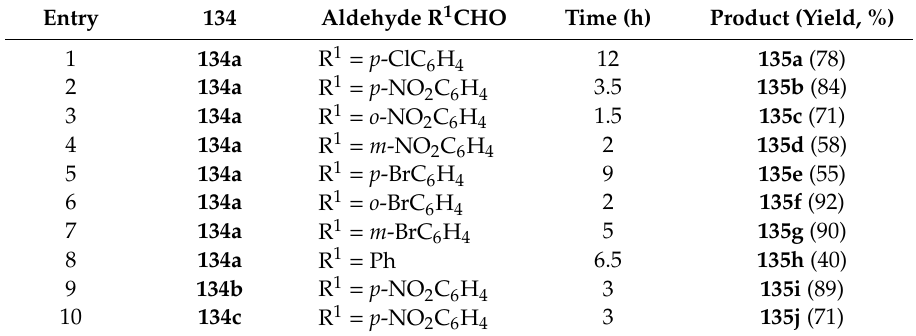
Table 9. Reaction time and yields of oxiranylketones 135a – j obtained in the reaction of ketoselenonium ylides 134a – c with aromatic aldehydes.